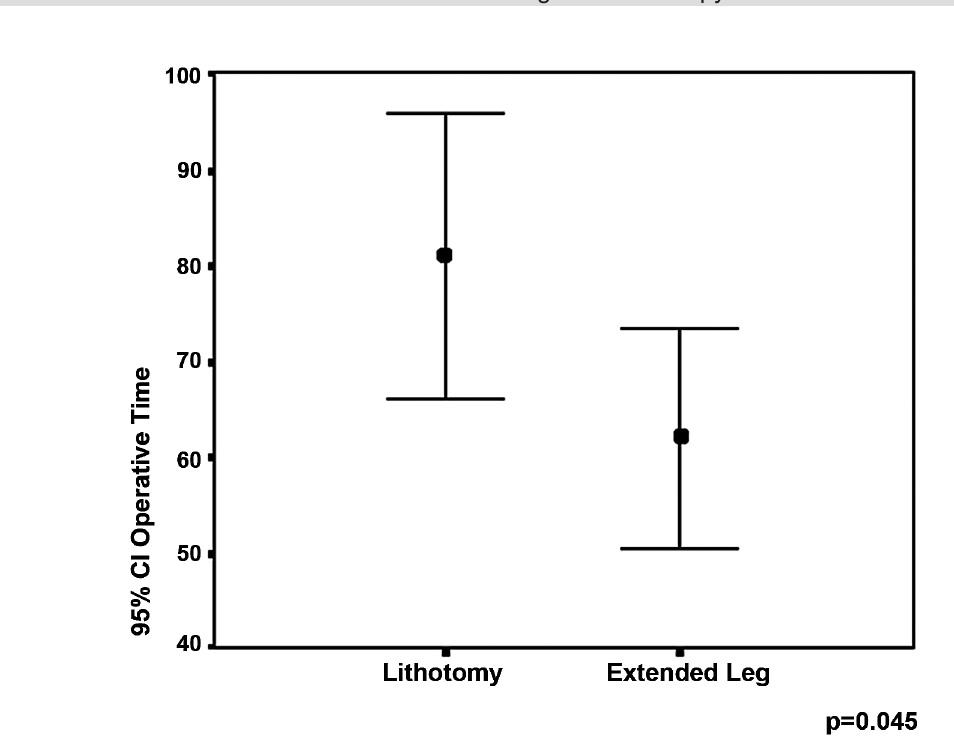
Figure 2 – Operative time for dorsal lithotomy and dorsal lithotomy with extended leg.